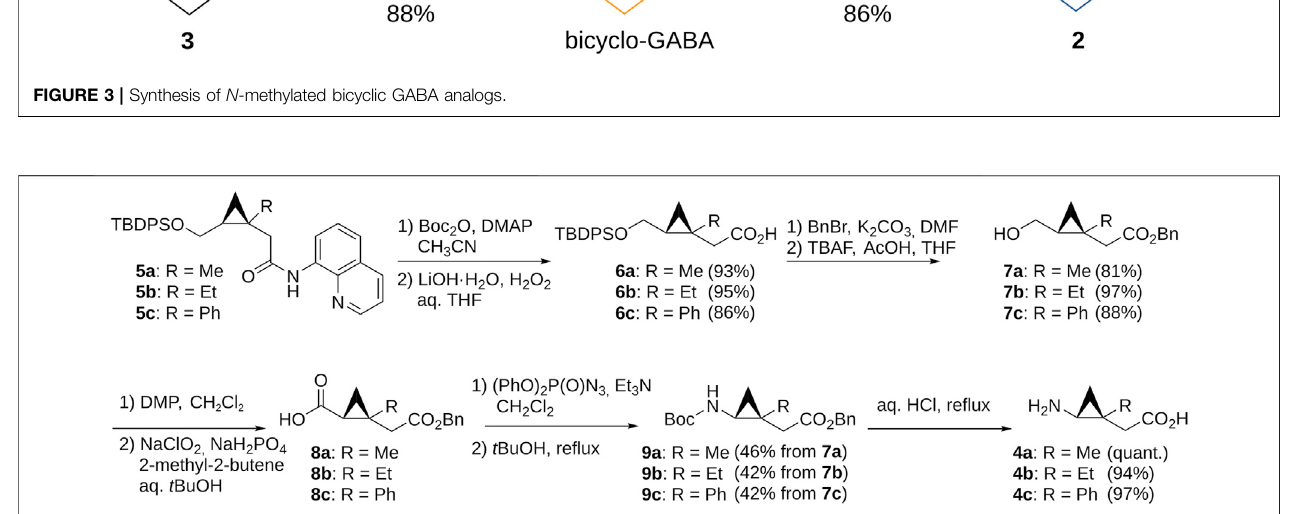
FIGURE 4 | Synthesis of GABA analogs containing the trisubstituted cyclopropane